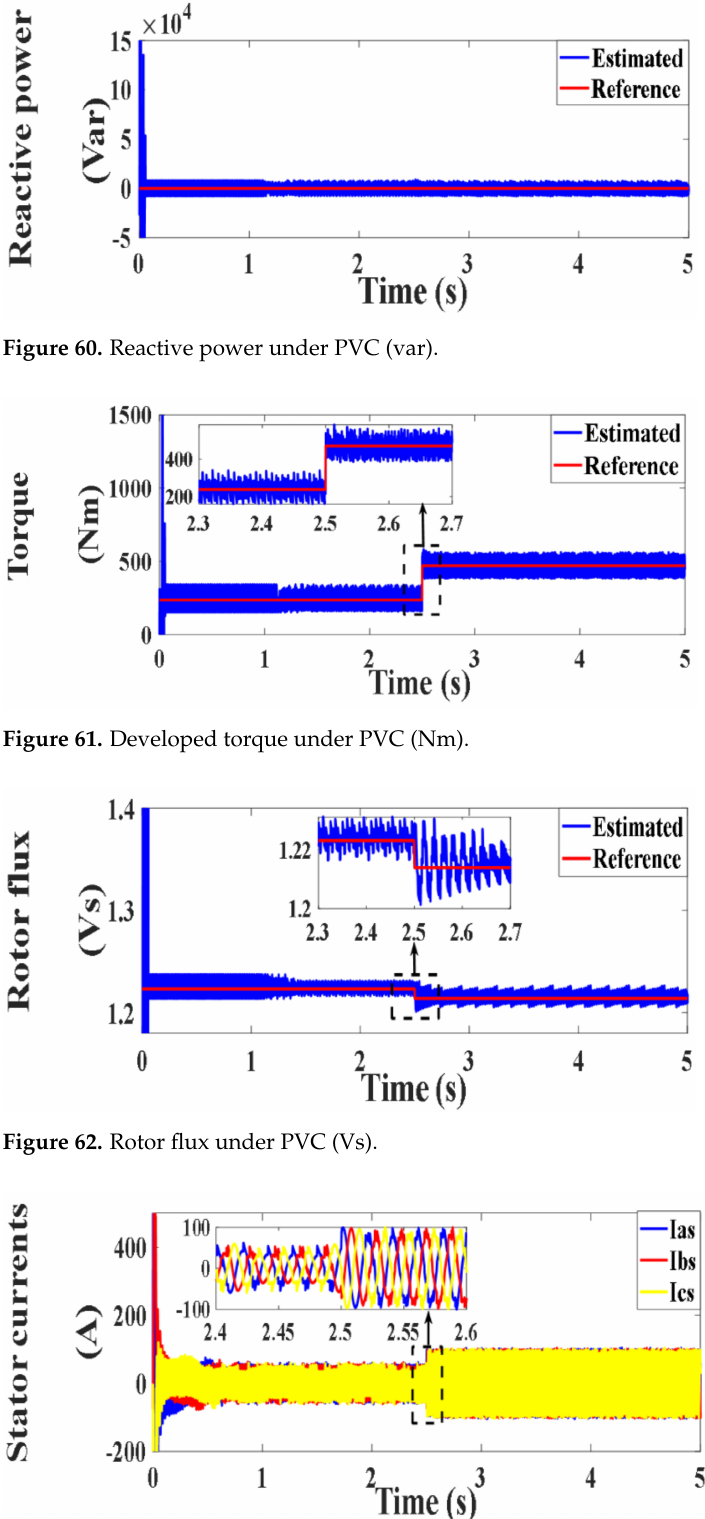
Figure 63. Stator currents under PVC